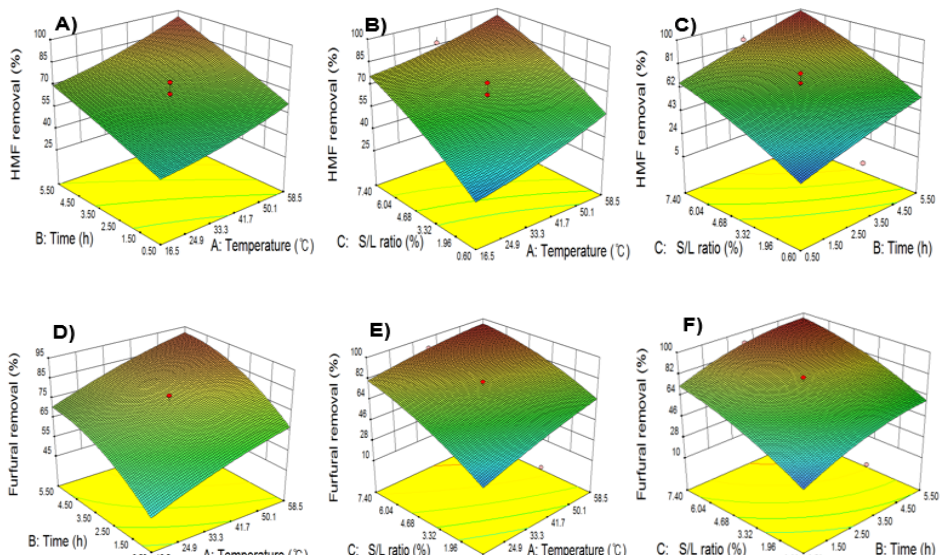
Figure 2. Response surface curves representing the effects of detoxification process conditions including extraction time, extraction temperature, and S-L ratio on 5-HMF and furfural removal. Time versus temperature ( A , D ); temperature versus S-L ratio ( B , E ); S-L ratio versus time ( C , F